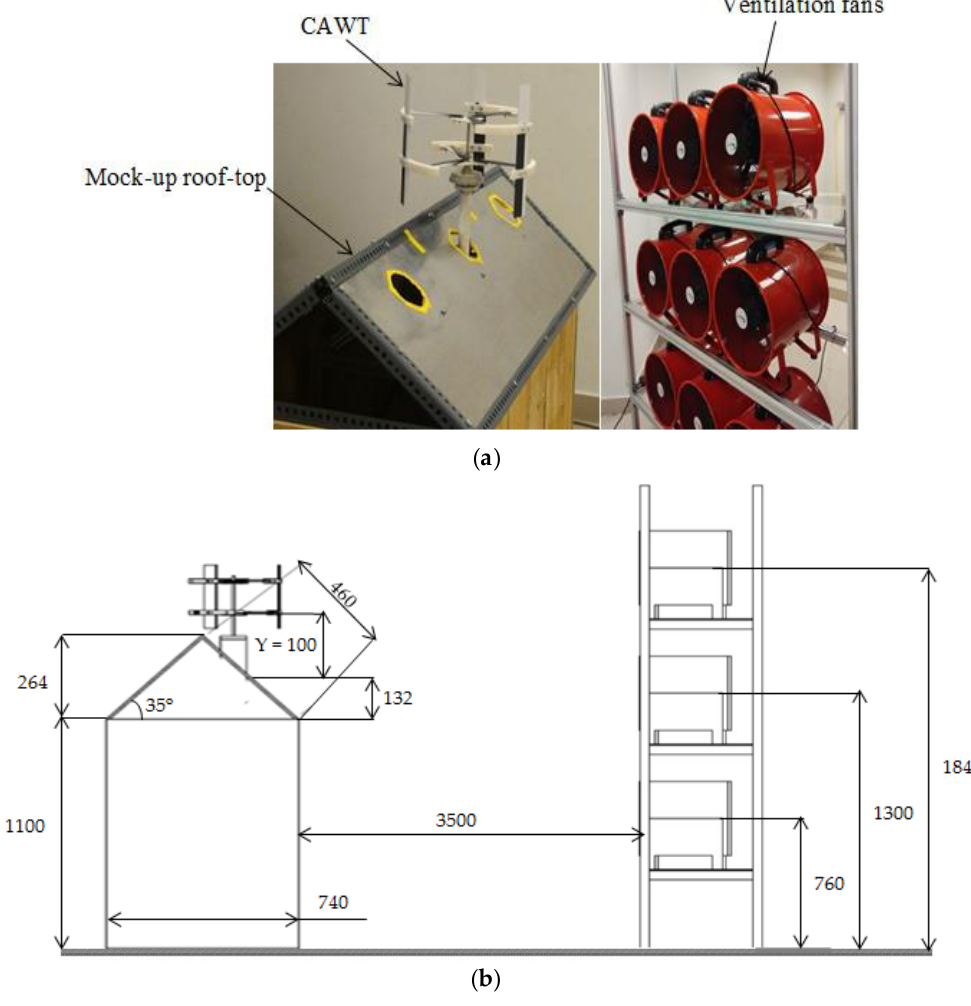
Figure 9. ( a ) Experimental set-up of the CAWT; and ( b ) detailed dimensions of a building integrated with a CAWT and dimensions of the ventilation fans (all dimensions in mm).